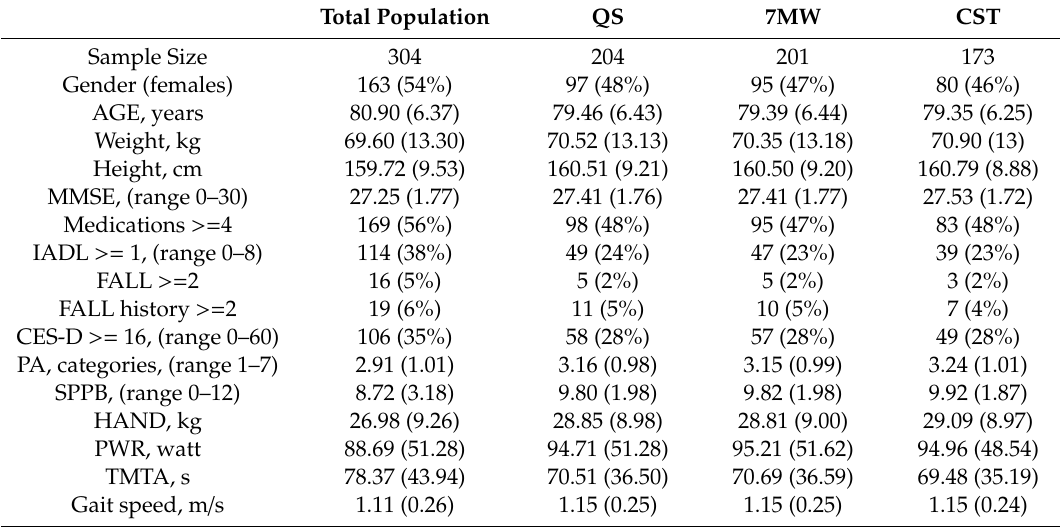
Table 1. Demographic and functional profiles of each subgroup undertaking the three functional